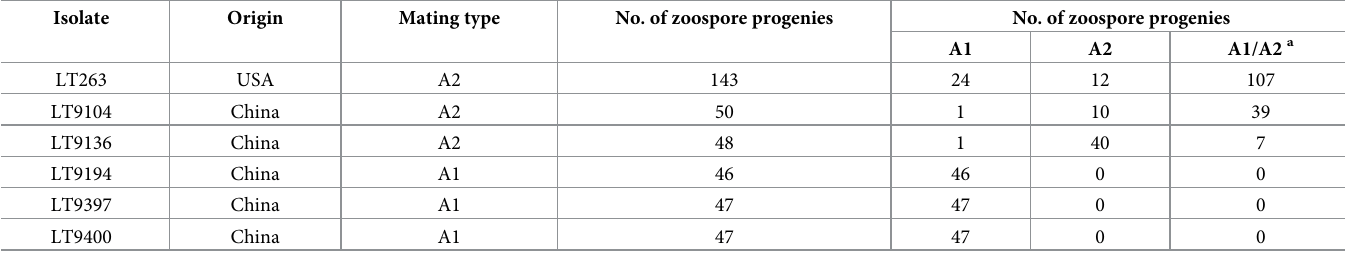
Table 1. Summary of mating type switch in zoospore progenies of P . capsici from the USA and China. Isolate